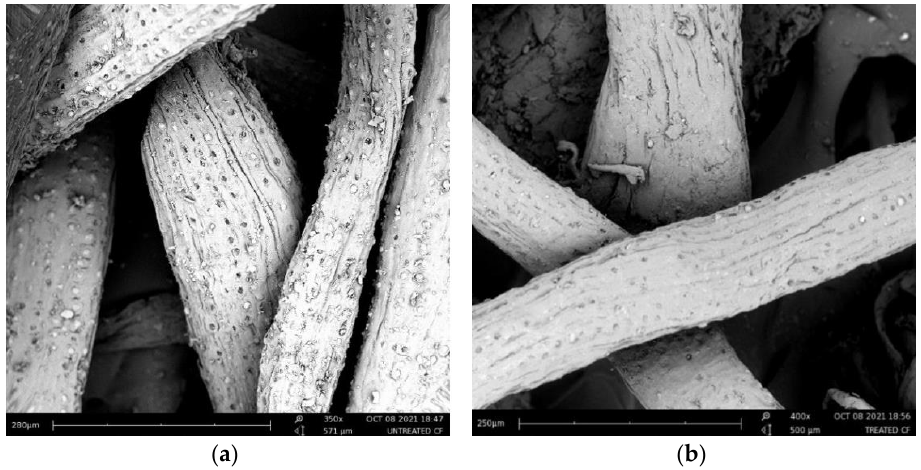
Figure 13. SEM of ( a ) untreated coir fibers and ( b ) pre-treated coir fibers